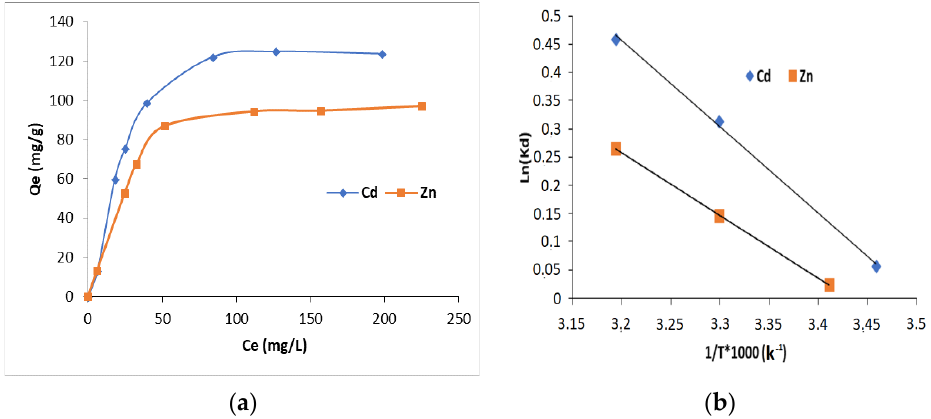
Figure 13. ( a ) Concentration effect on the adsorption of cadmium and zinc on HAp/CTs 20/80; ( b ) adsorption thermodynamics of Cd 2+ and Zn 2+ onto composite HAp/CTs 20/80. The value of ∆ G ◦ falls as temperature rises, indicating that adsorption is spontaneous for both metal ions Cd 2+ and Zn 2+ , and the value of the standard enthalpy ∆ H ◦ is positive, which shows that the adsorption is endothermic [47–51].